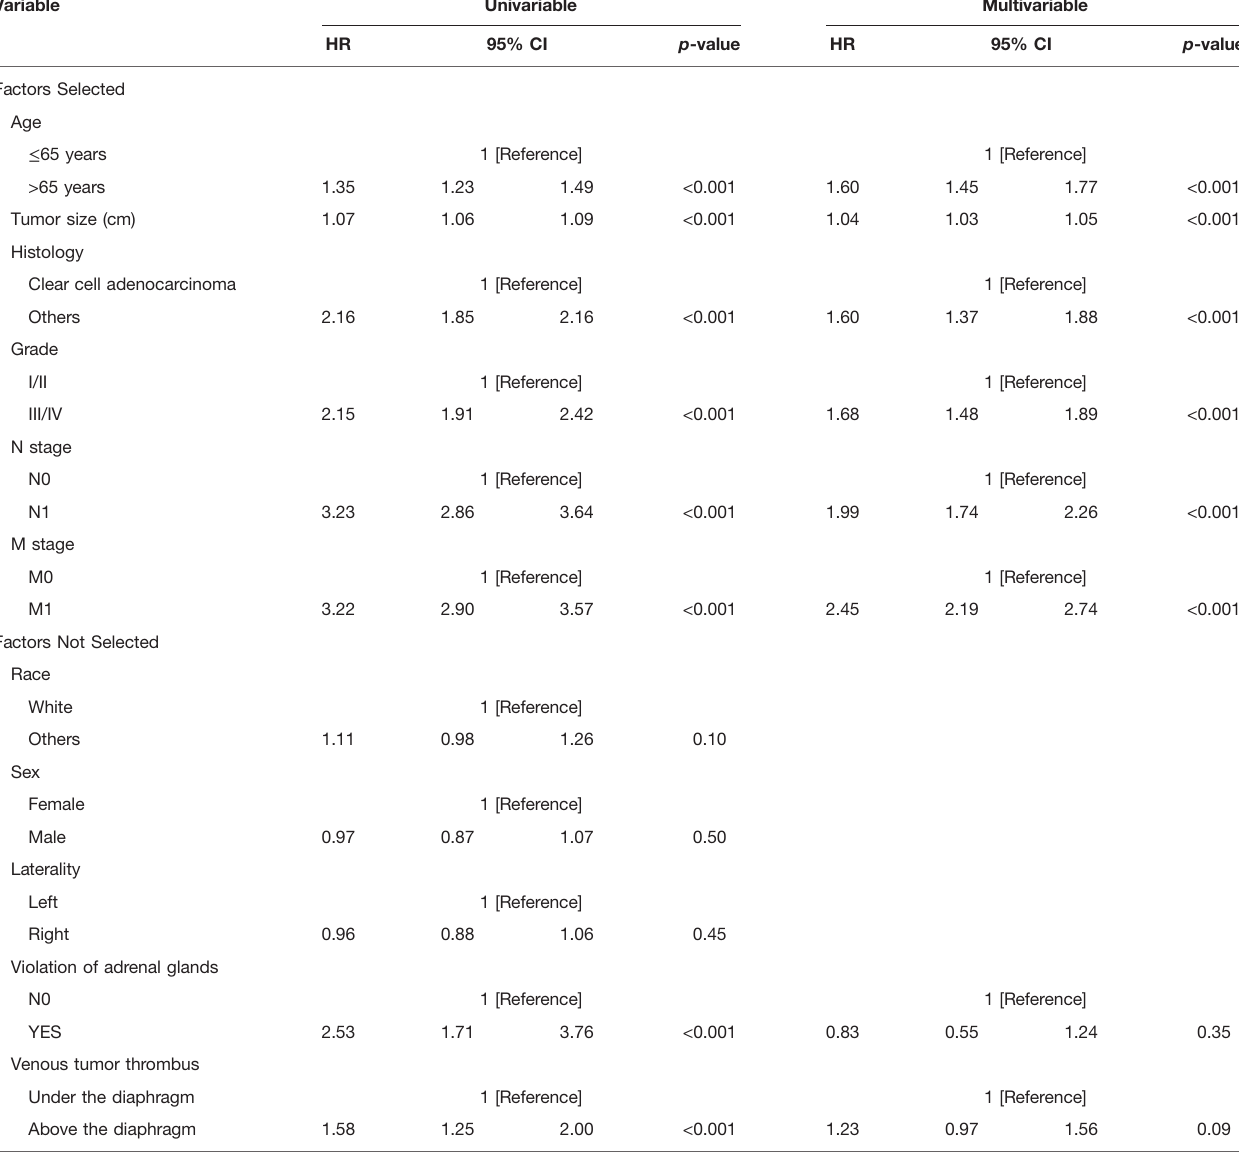
TABLE 3 | Cox proportional hazards regression model showing the association of variables with overall survival.